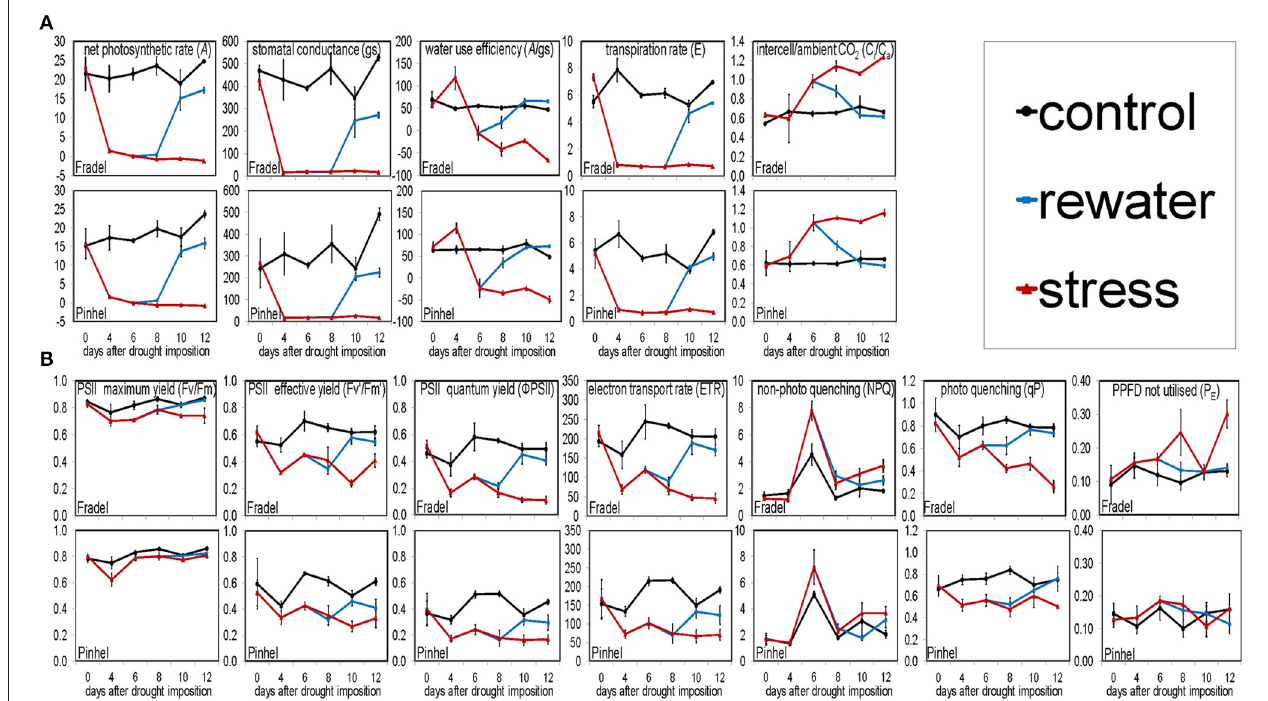
FIGURE 2 | Effects of drought stress and rewatering on gas exchange (A) and chlorophyll fluorescence (B) parameters in cowpea. Lines indicate the well-watered control (black), drought-stressed (red), and rewatered plants (blue; n = 6; error bars = SD divided by 2 for better visibility).